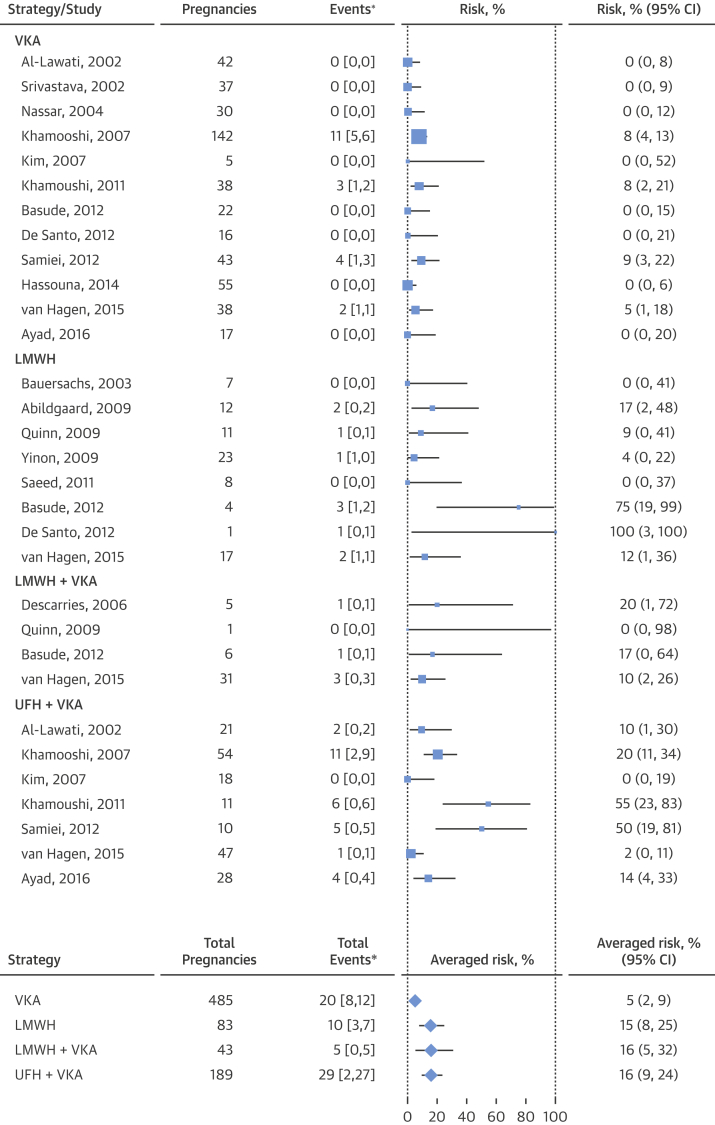
Forest Plot of the Composite Maternal OutcomeThe individual and composite maternal endpoints as reported by each publication included in the meta-analysis. The forest plot represents an averaged risk of the composite outcome, weighted by study sample size. *Values in brackets are number of deaths, number of prosthetic valve failures or thromboembolisms. CI = confidence interval; VKA = vitamin K antagonist; other abbreviations as in Figure 1.